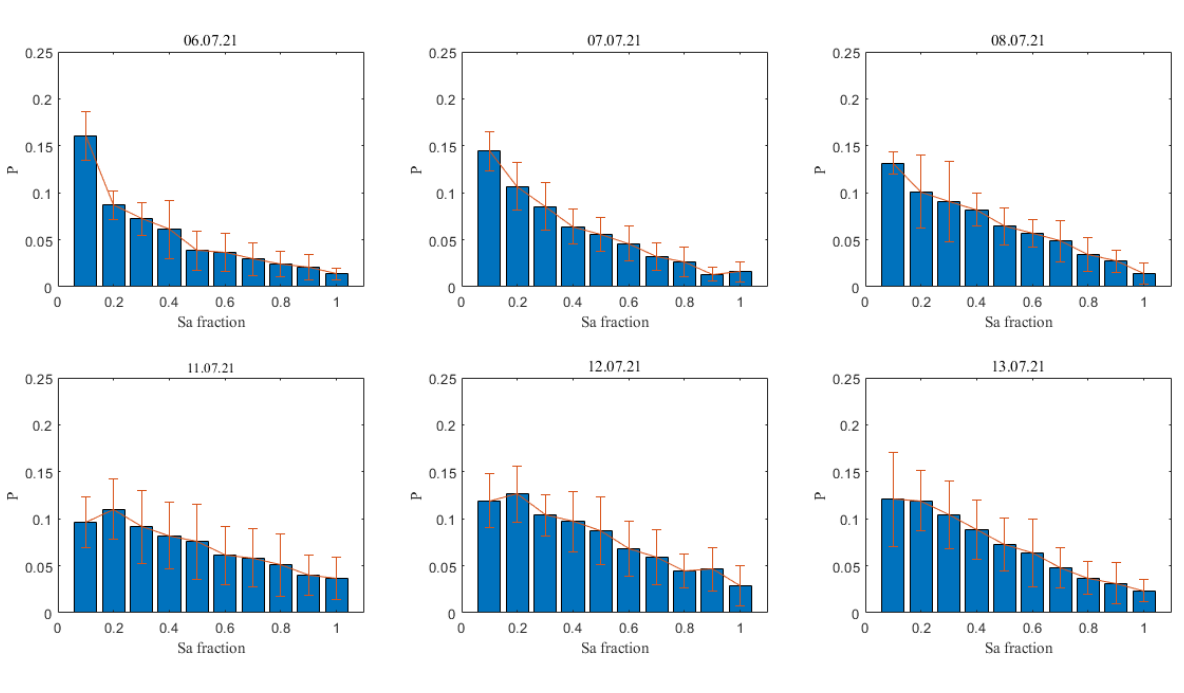
Figure 6 The effect of Seteria adherents fraction (F) in the pixel on misclassification probability (P) on 6 days of measurements. The mean was calculated based on 5 different sowing plates. Error bars represent the probabilities’ standard